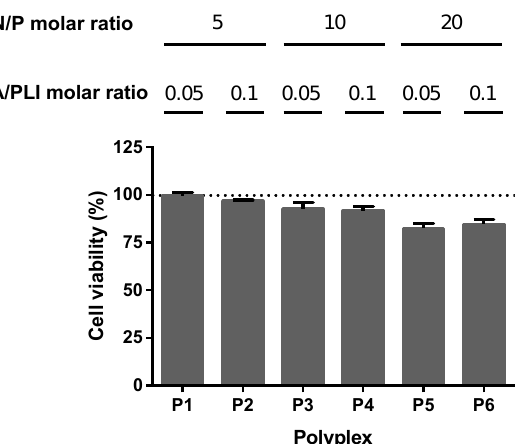
Figure 5. Effect on cell viability of miRNA-34a-loaded nanopolyplexes on triple negative breast cancer MDA-MB-231 cells. Cells were treated for 24 h with the indicated polyplex; N/P and HA/PLI molar ratios for each polyplex are included in the graph. The cell survival was determined by the PrestoBlue method as a percentage of the control. Data are expressed as the mean ± standard error of experiments performed in triplicate.